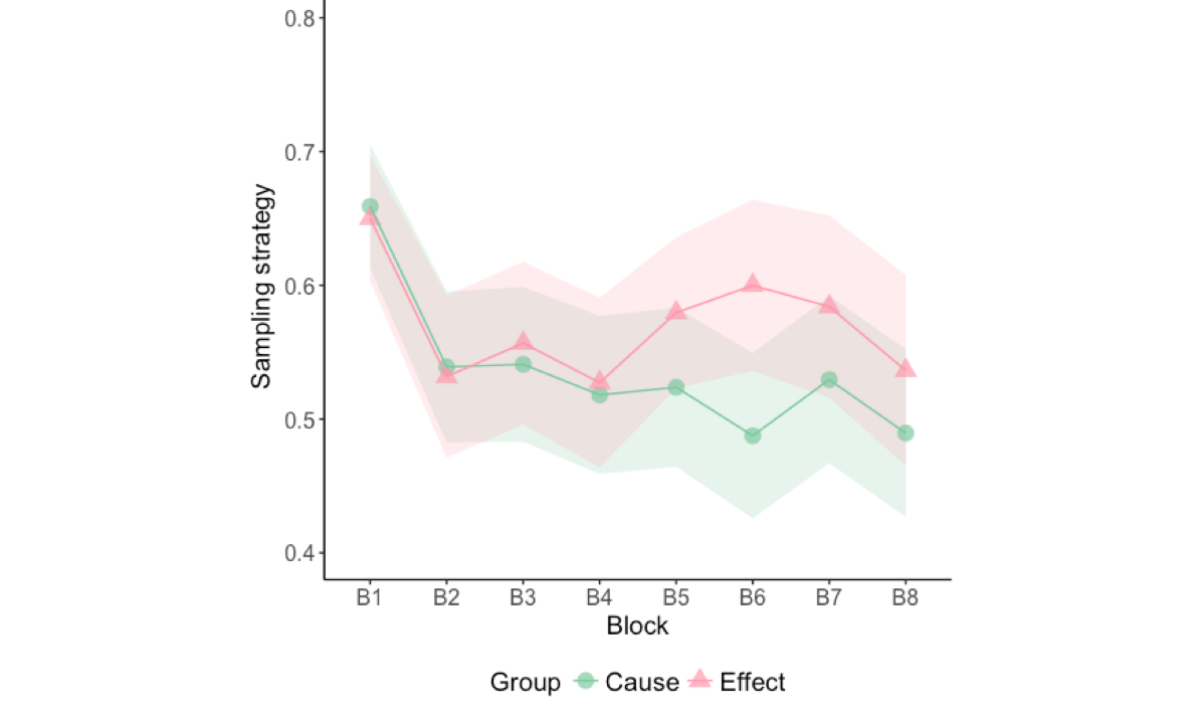
Figure 5. Mean sampling strategy index for each block of 5 trials for the cause group and for the effect group. Ribbons depict 95%